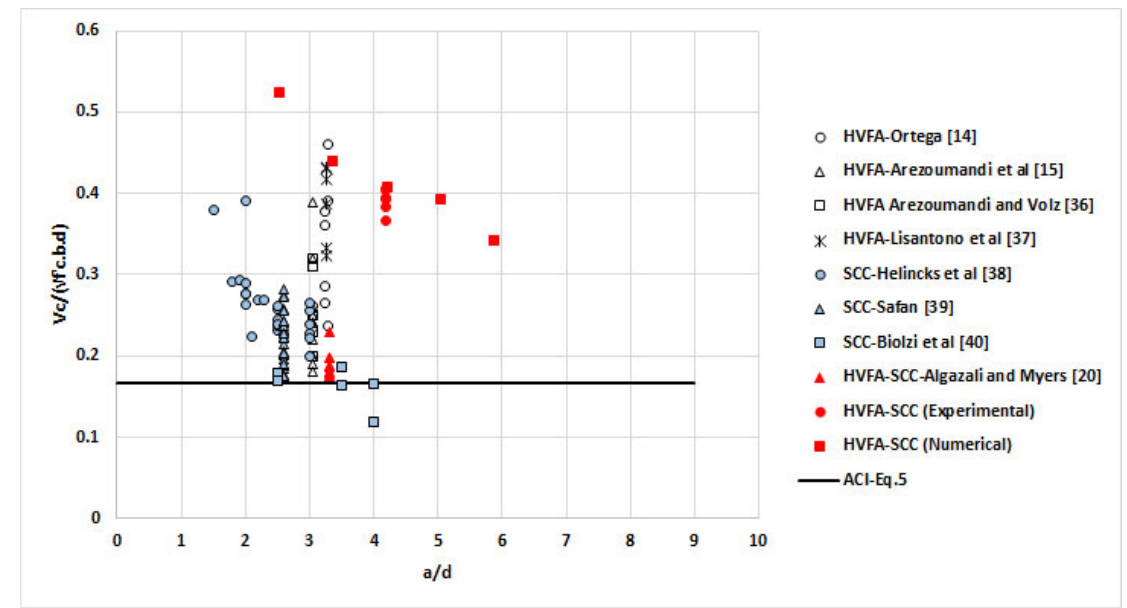
Buildings 2021 , 11 , x 18 of 21 Figure 18. HVFA ‐ SCC shear strength in the database of normalized shear strength vs. longitudinal reinforcement ratio. The value of HVFA ‐ SCC shear strength from the results of this study is also presented in other non ‐ conventional concrete shear strength databases [14,15,36–40] (see Figures 19 and 20). Although the amount of data used in constructing Figures 19 and 20 is limited, it shows that the non ‐ conventional concrete meets the shear strength values estimated from the ACI design code. In Figures 19 and 20, the value of HVFA ‐ SCC shear